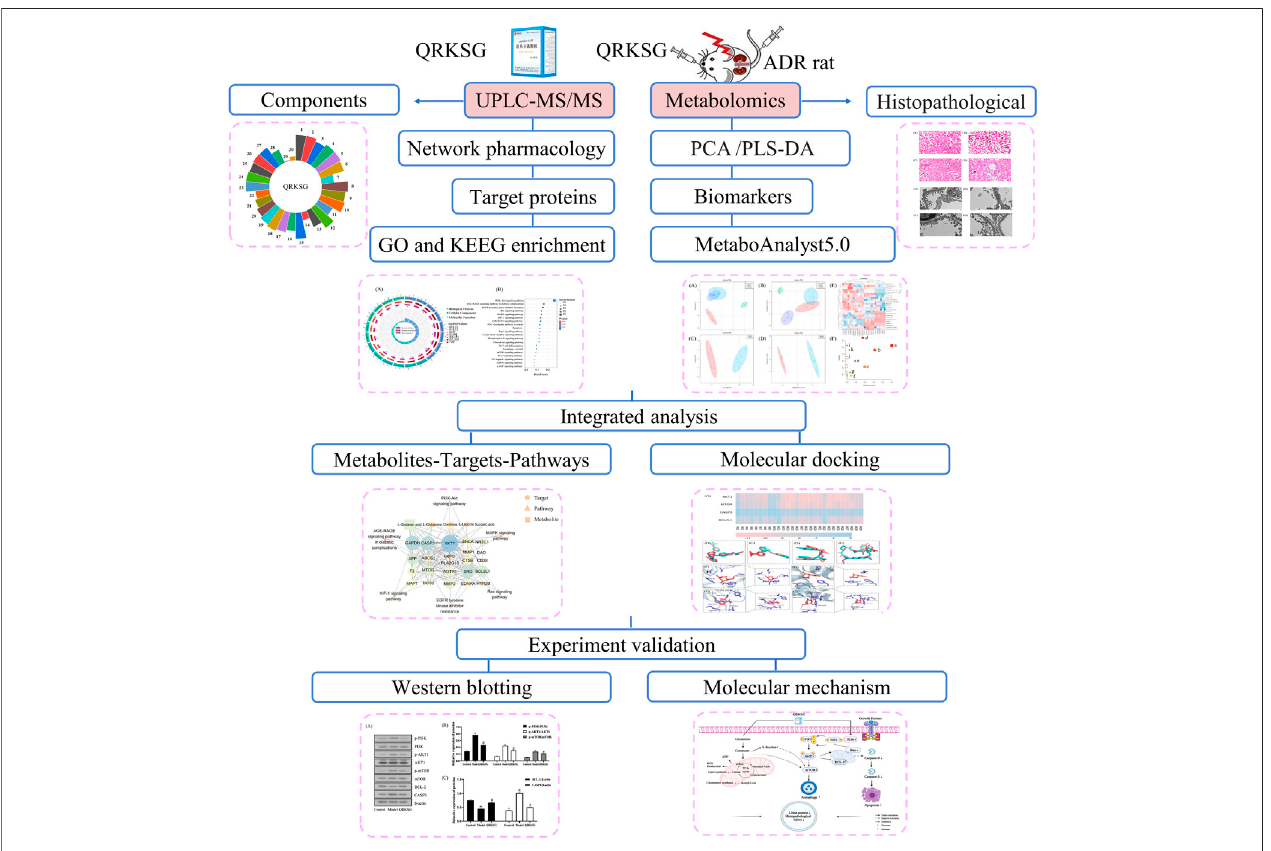
FIGURE 1 | Flow chart of the research